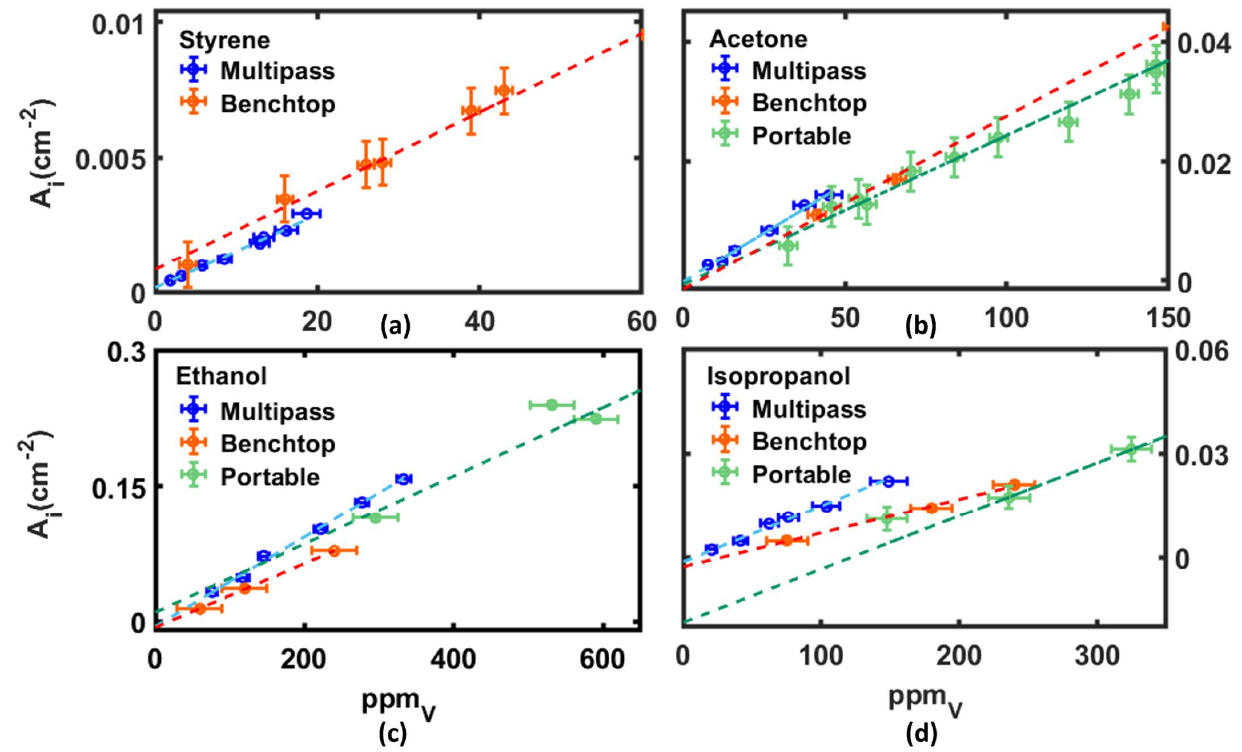
Figure 4. Enlargement view of the calibration of the integrated absorbance, normalized at the optical path, vs. ppm v for styrene ( a ), acetone ( b ), ethanol ( c ) and isopropanol ( d ) obtained with the multipass (light blue line), benchtop (red line) and the portable device (green line), respectively. The whole calibration curves of the integrated absorbance vs. ppm v obtained with the three setups are reported in Figure S3 of the Supporting Information. The integrated area errors were 0.1 × 10 − 4 cm − 2 for multipass data (blue), 4∙10 − 4 cm − 2 for benchtop data (red) and 0.001 cm − 2 for portable data (green).